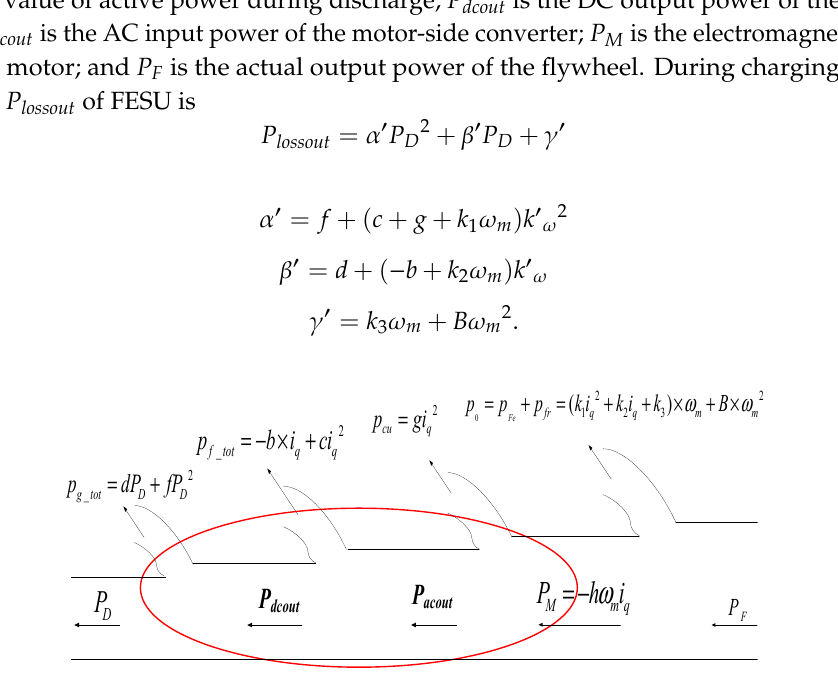
Figure 6. Energy flowing in the FESU during discharge.